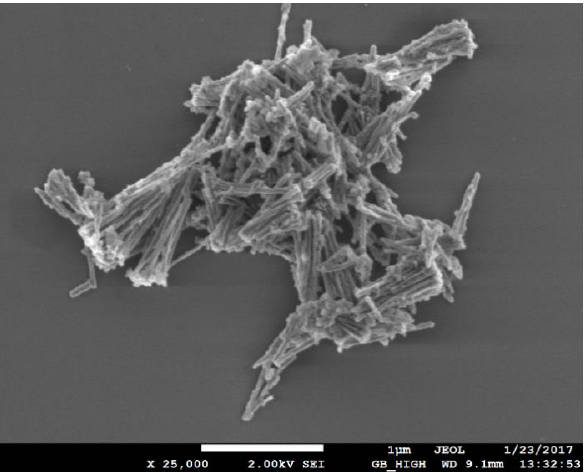
Figure 3. SEM micrograph of Ni nanowires.